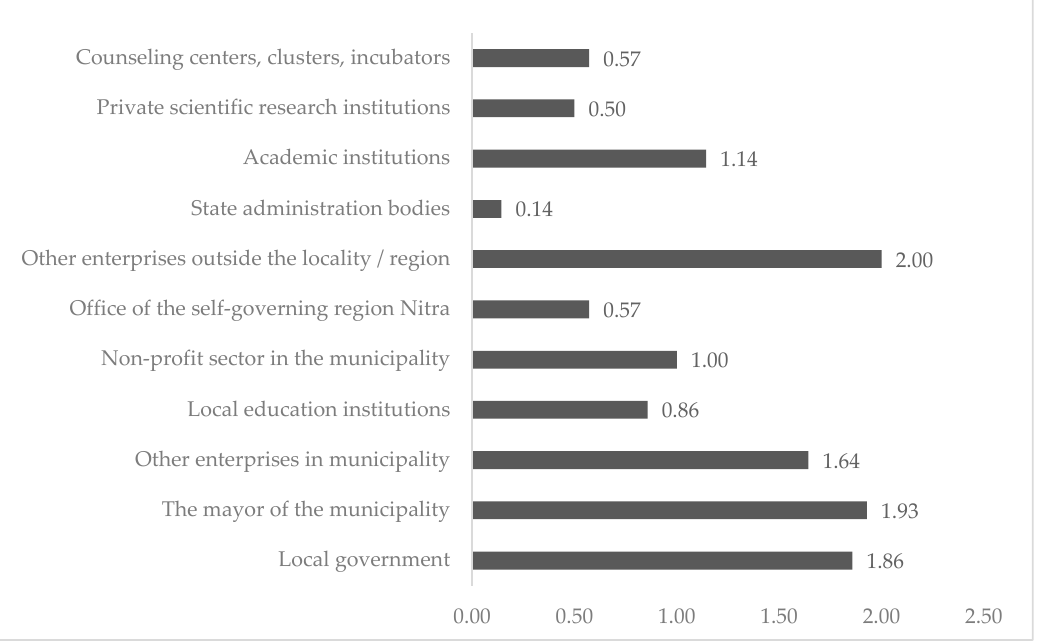
Figure 3. Average importance of networking with selected actors on scale 0–3.